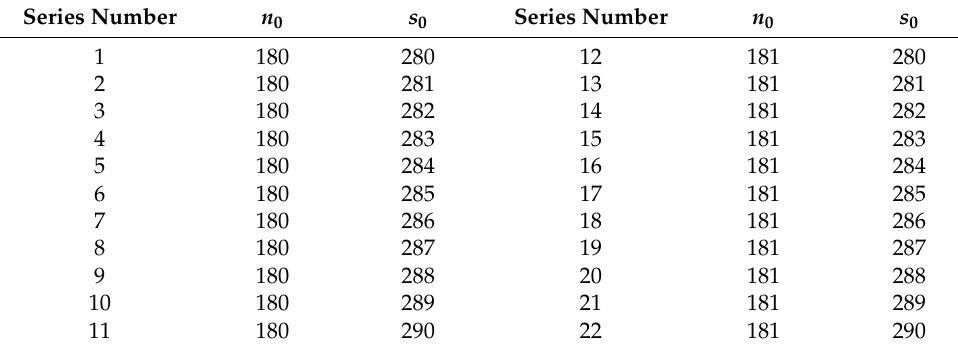
Table 5. The corresponding threshold for each number.